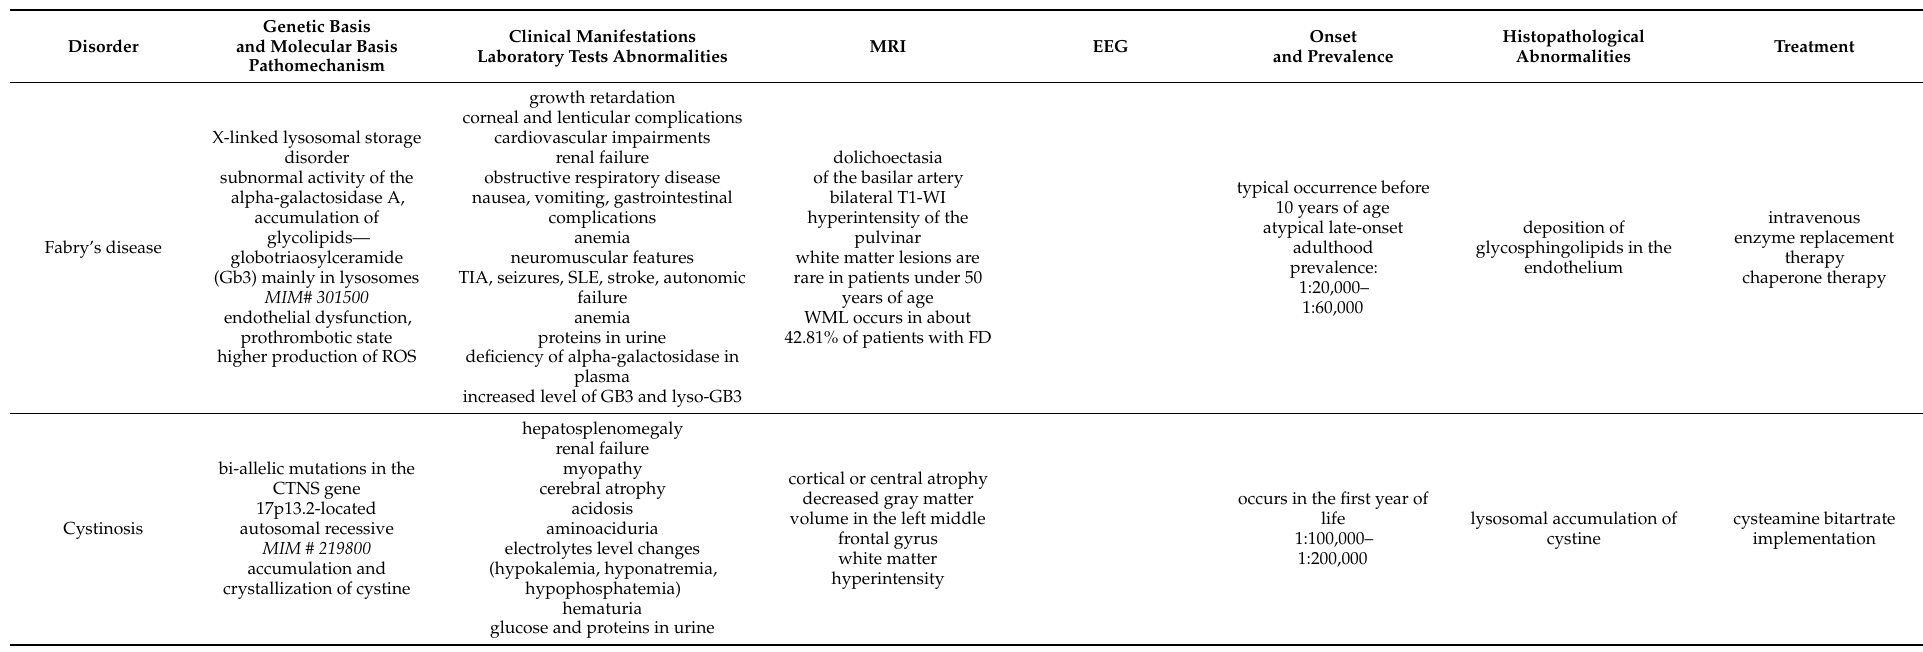
Table 3. This table shows characteristic features of Fabry’s disease and